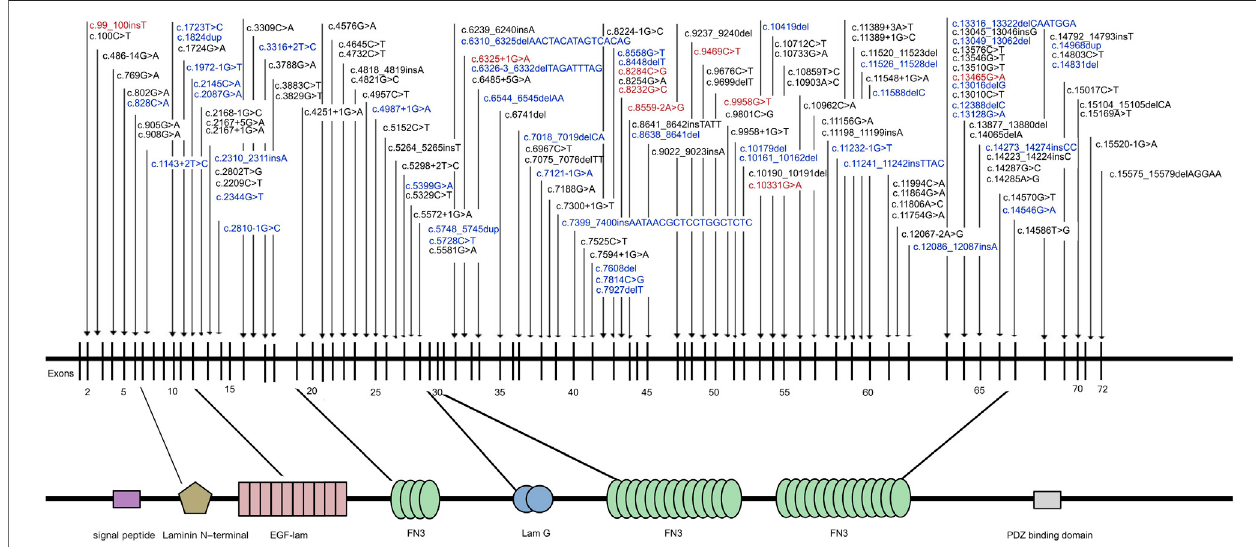
FIGURE 2 | Naturally occurring mutations of USH2A detected in patients with IRD. Blue indicates novel mutations fi rst reported in this study; Red indicates mutations were founder mutations identi fi ed in East Asian Populations.